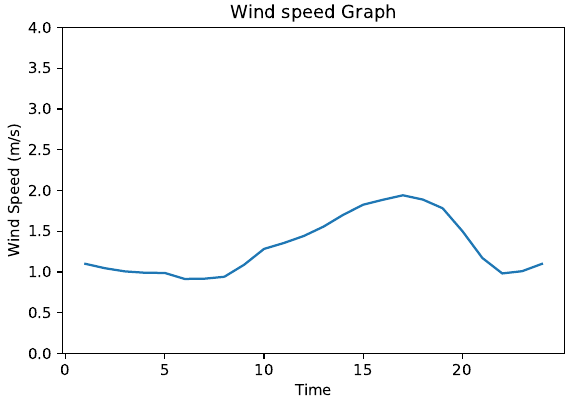
Figure 8. Average annual wind